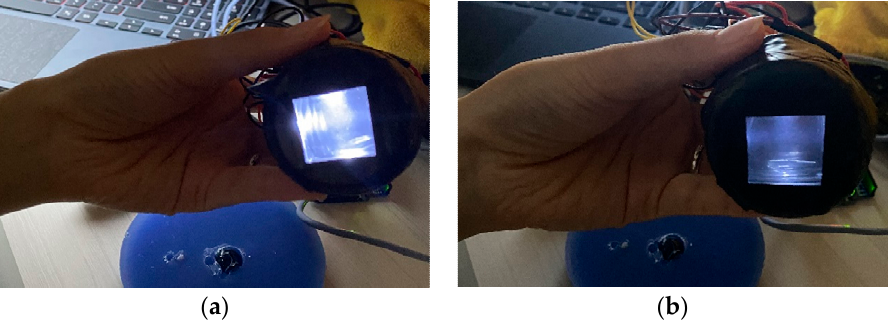
Figure 16. Adjusting the optical waveguide’s brightness: ( a ) maximum brightness, ( b ) medium brightness.